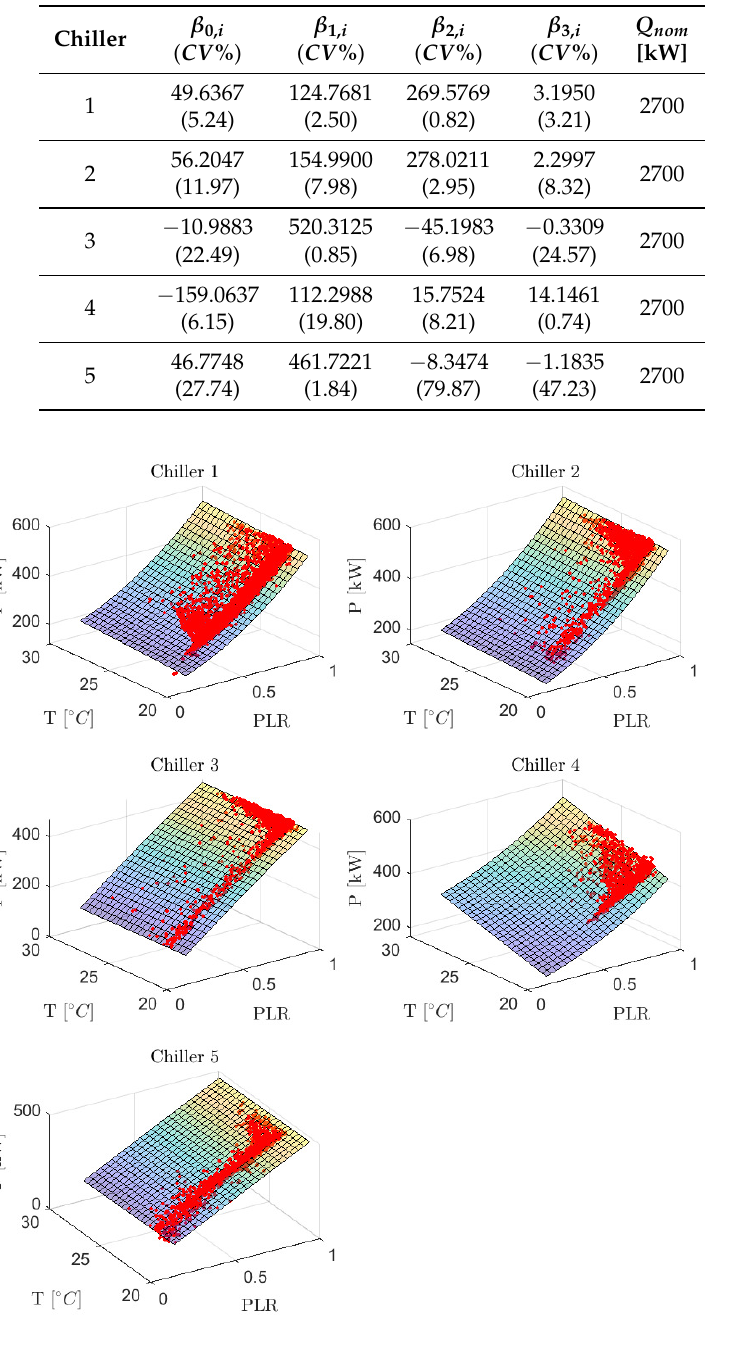
Figure 5. Three-dimensional representation of power consumption models. Red dots represent the experimental